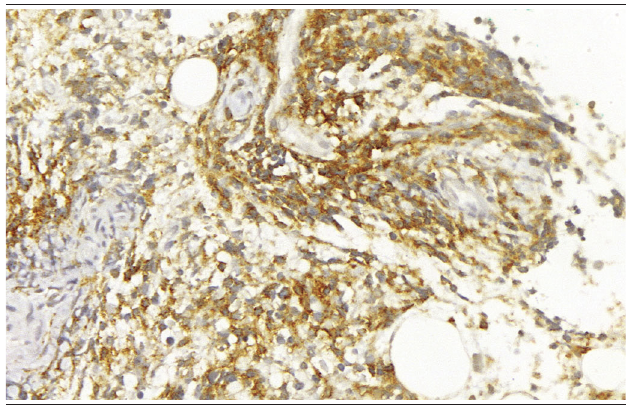
figurE 6 − Bone marrow biopsy, immunohistochemistry (CD10, 400×) Positivity for CD10 is a prognostic factor in the context of ALL. ALL: acute lymphoblastic leukemia.